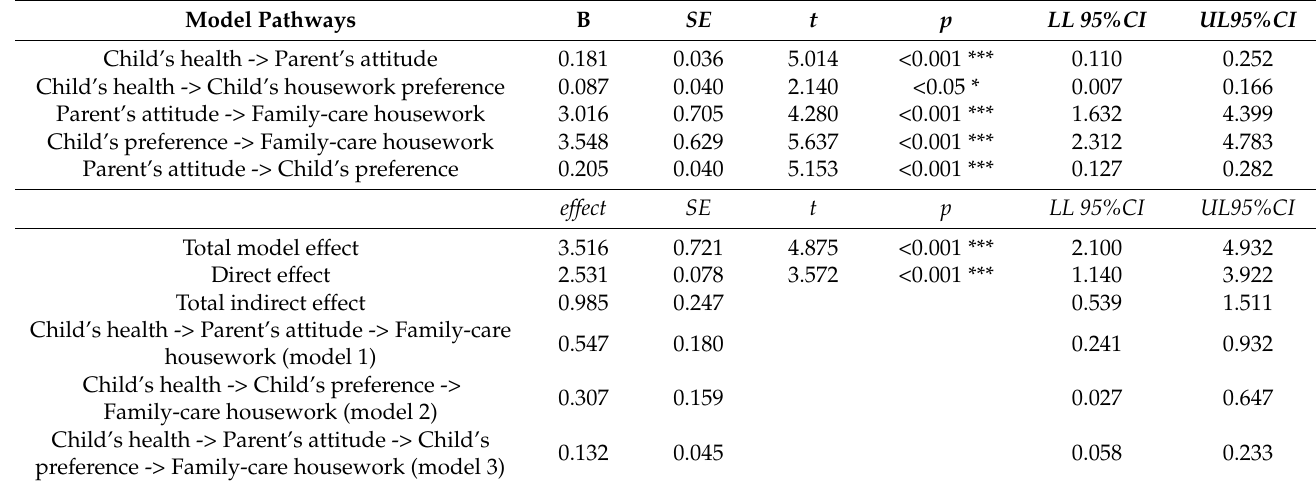
Table 4. Serial mediation effects on the relationship between Child’s health and Family-care